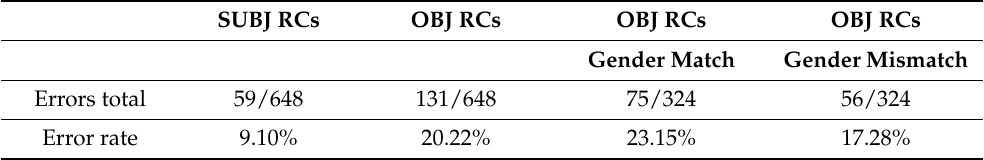
Table 1. Errors on Version 1 of the experiment.